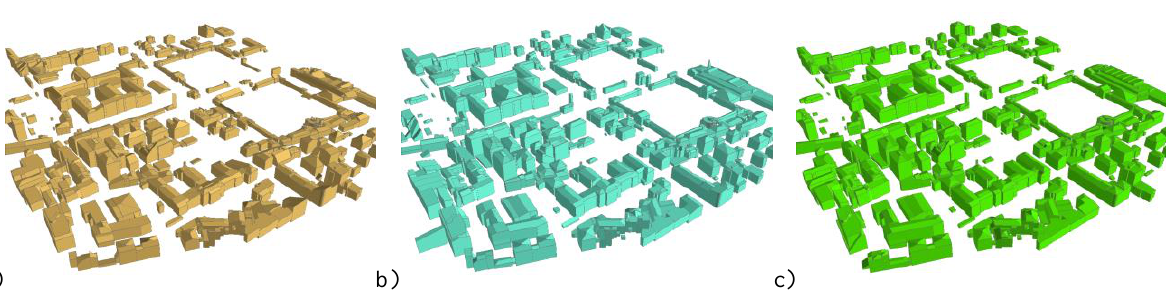
Figure 4. LoD2 building models generated using the 1:1,000 topographic map with GeoEye DSM (a), airborne images DSM (b) and LiDAR DSM (c).